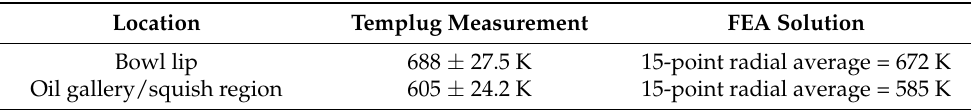
Table 2. Templug experimental data compared with finite element analysis (FEA) surface temperature at similar